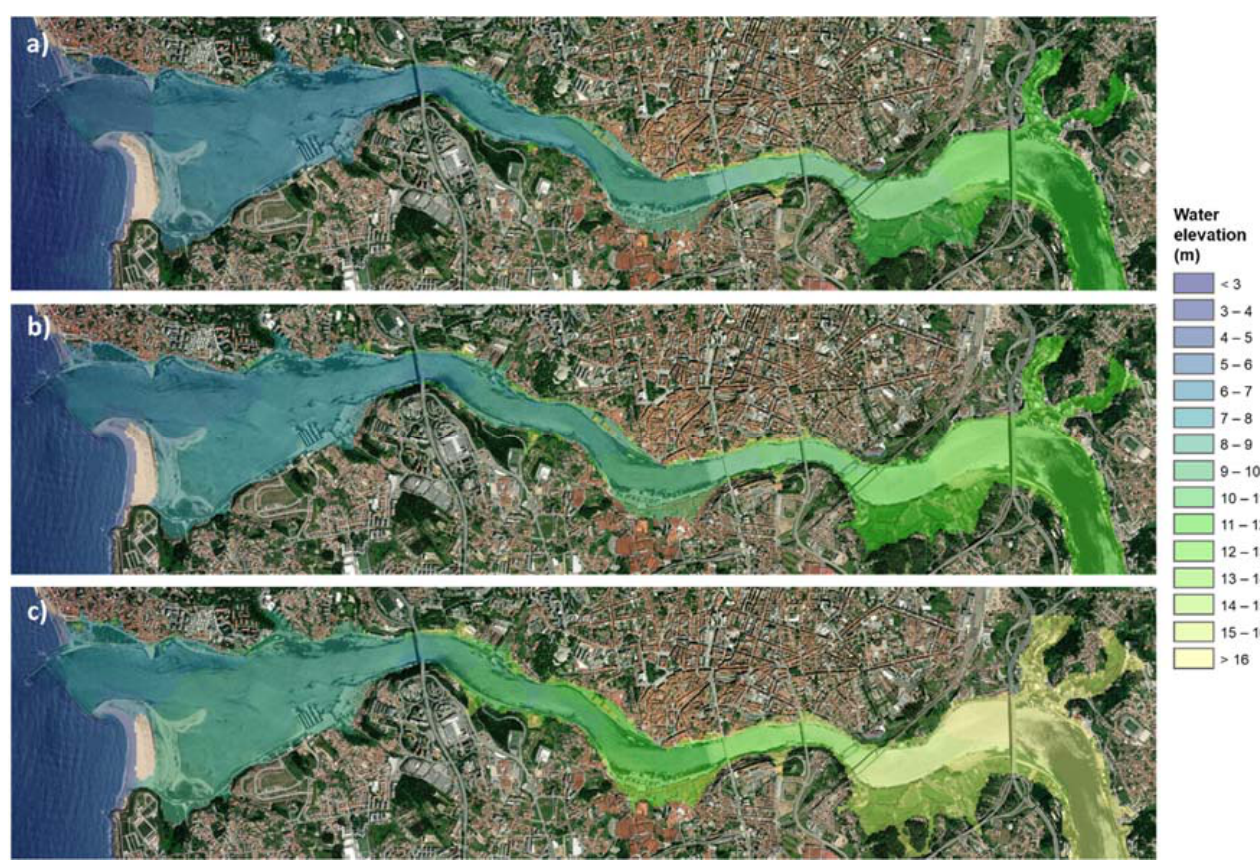
Figure 4. Water levels in the Douro estuary forecasted for the ( a ) S1 scenario (historical, 50 ‐ year EFD return period), ( b ) S14 scenario (historical, 100 ‐ year EFD return period), and ( c ) S27 scenario (historical, 1000 ‐ year EFD return period) (base map sources: Esri, Maxar, GeoEye, Earthstar Geographics, CNES/Airbus DS, USDA, USGS, AeroGRID, IGN, and the GIS User Community).